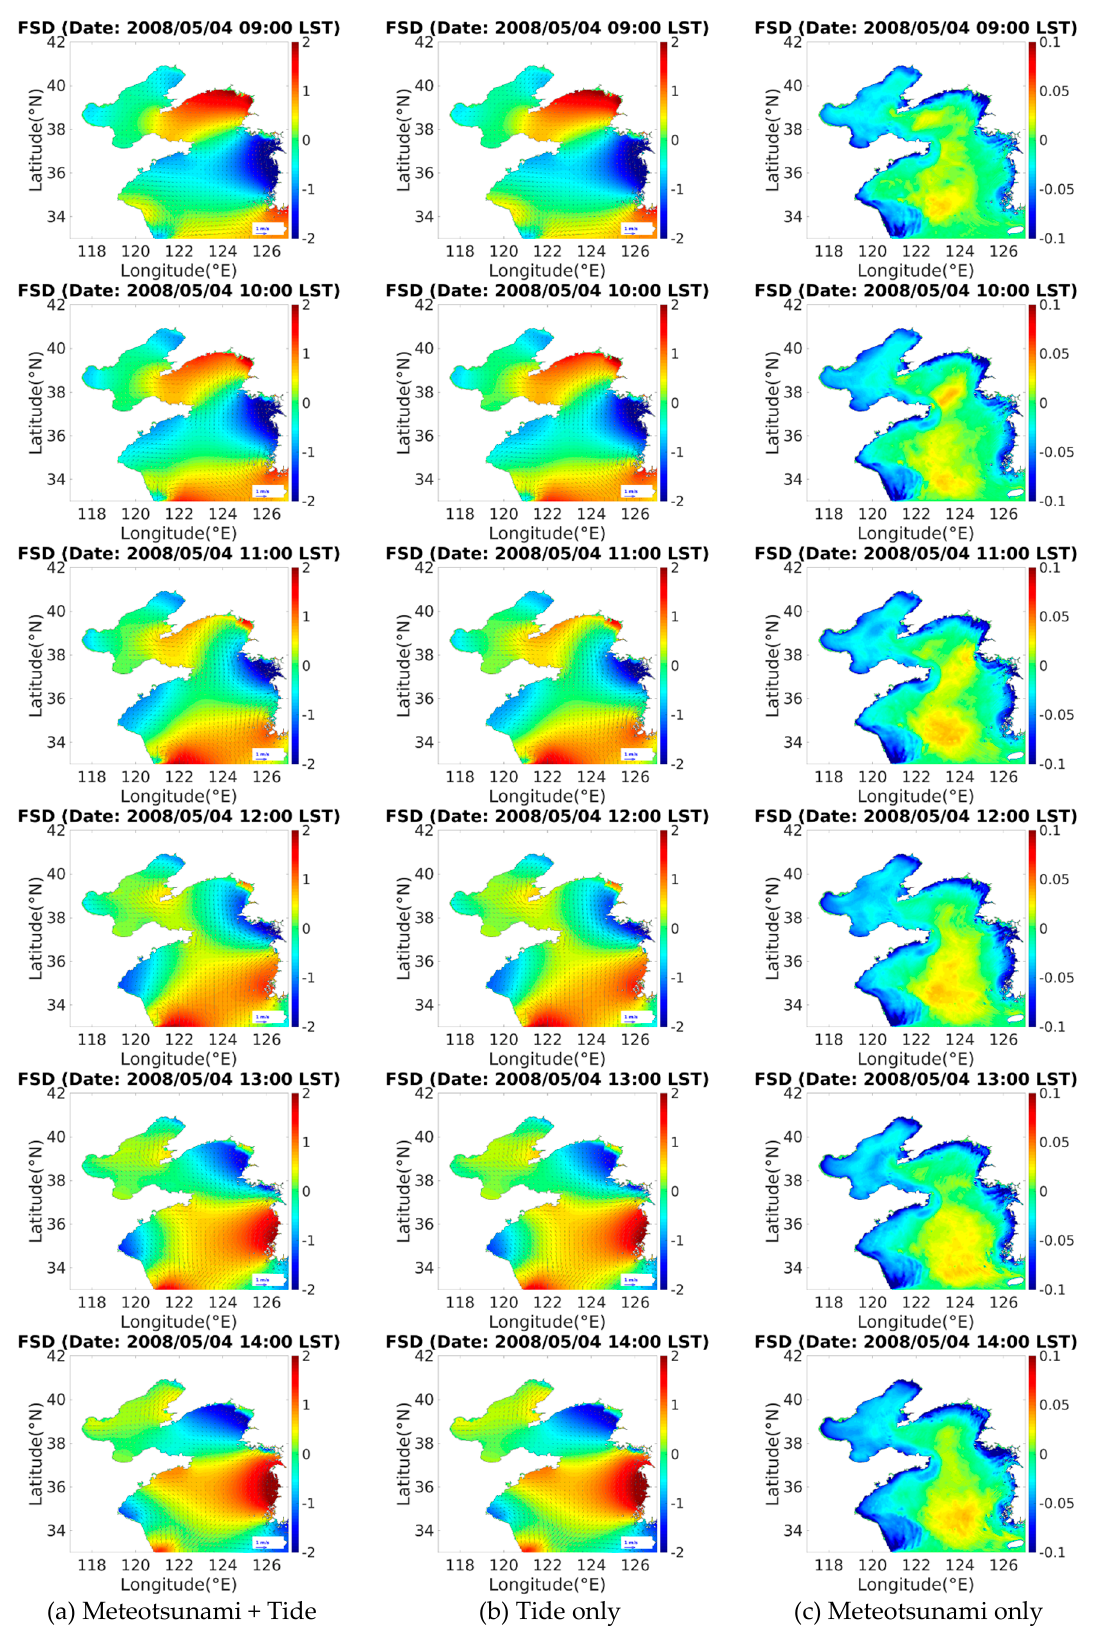
Figure 10. Comparison of the free surface displacement (FSD) change with tide modeling in the Yellow Sea during the meteotsunami that occurred in May 2008. ( a ) FSD change of the meteotsunami with tide modeling; (b ) FSD change of tides; (c ) FSD change of the meteotsunami only.